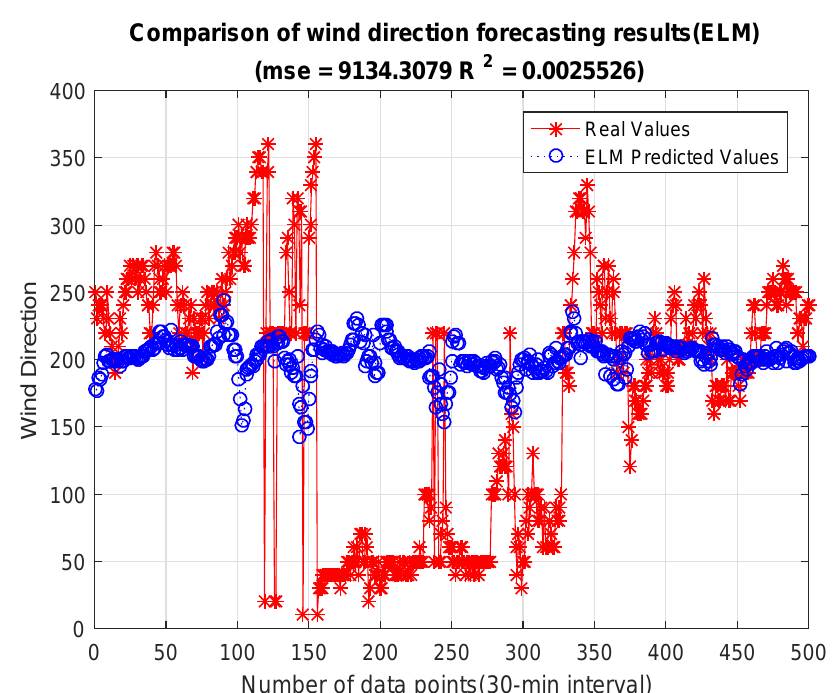
Figure 21. The portraits of comparison of wind direction forecasting results (ELM) in OSWFs in Yangshan port, Shanghai from 22 August 2017 to 22 August 2018 (number of predicted data pieces is